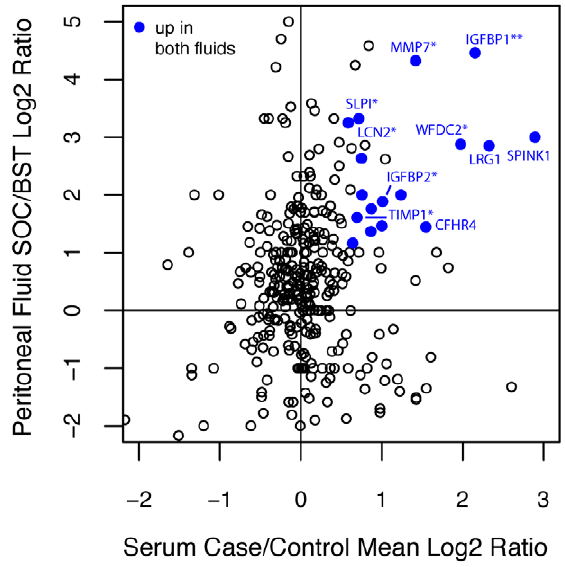
Figure 3. Comparison by log2 ratio of serum to peritoneal ascites fluid. Proteins up-regulated in both fluids are colored blue. *Benchmark marker validated by ELISA assay; **New marker validated by ELISA